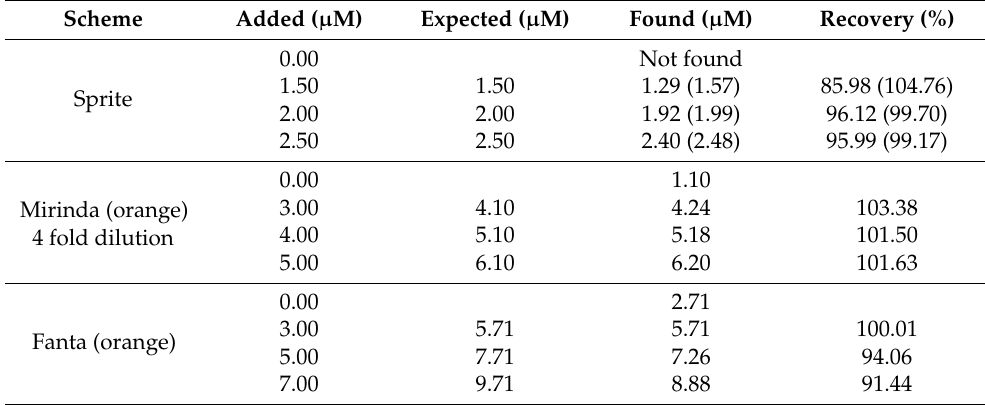
Table 7. Performance of modified sensor for sunset yellow determination in real sample.